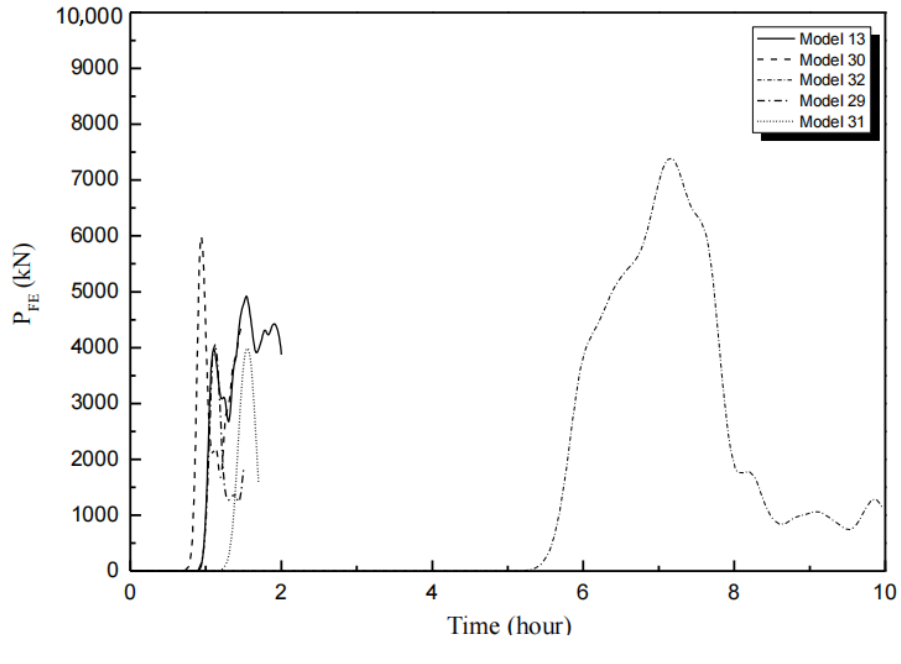
Figure 8. Axial strength versus time for model numbers 13, 29–32.